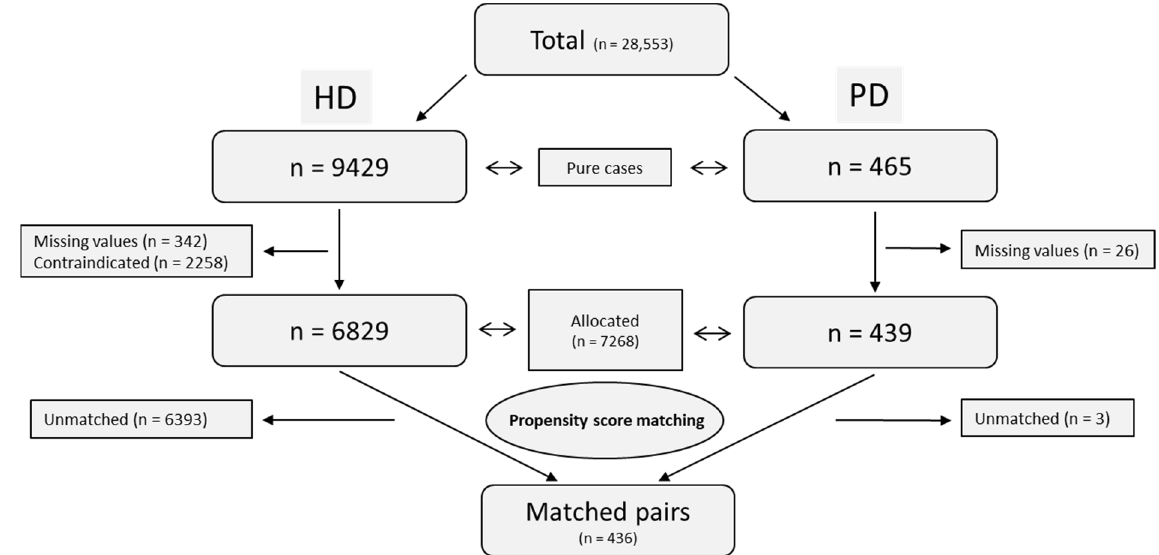
Figure 1. Flowchart study population.